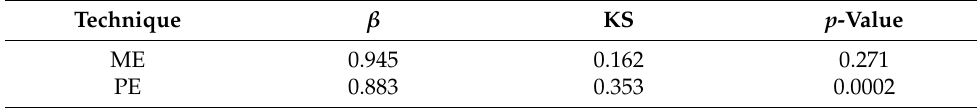
Table 16. Different estimators for COV-P data.